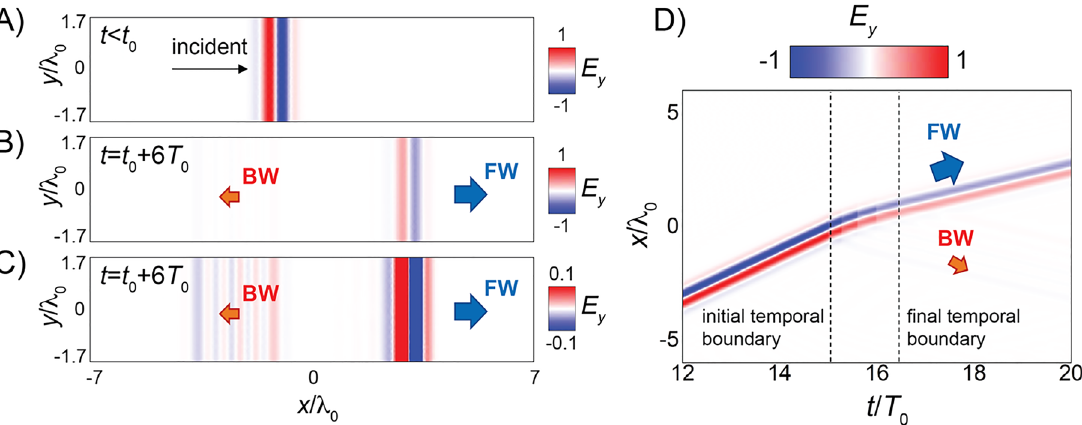
Figure 6: Parameters as in Figure 5 (Chebyshev design), but broadband pulsed excitation. (A), (B) Numerically computed instantaneous field maps (normalized electric field) at time instants before the initial temporal boundary and after the final one, respectively. (C) Same as panel (B), but with a saturated color scale, so as to better highlight the BW component. (D) Corresponding space-time map, with the vertical dashed lines indicating the initial and final temporal boundaries.